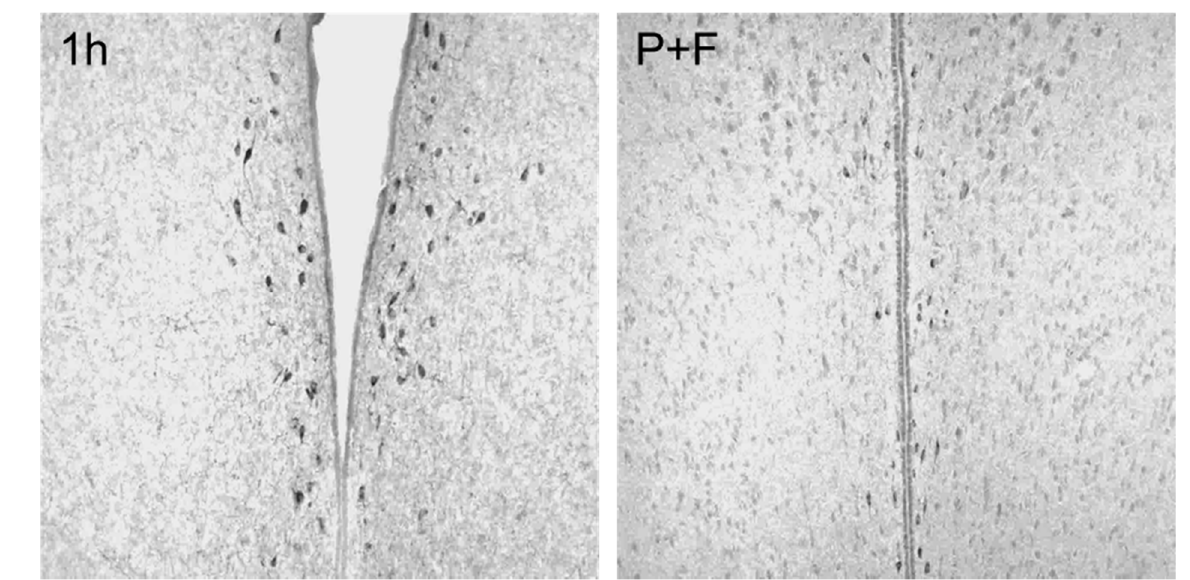
Figure A13. Somatostatin immunoreactivity in the medial periventricular nuclei of Syrian hamsters. Comparison between 1 h manual sleep deprivation (1 h, group 3a) and sexual stimulation with pheromone and females (P+F, group 1). Magnification: 50×.